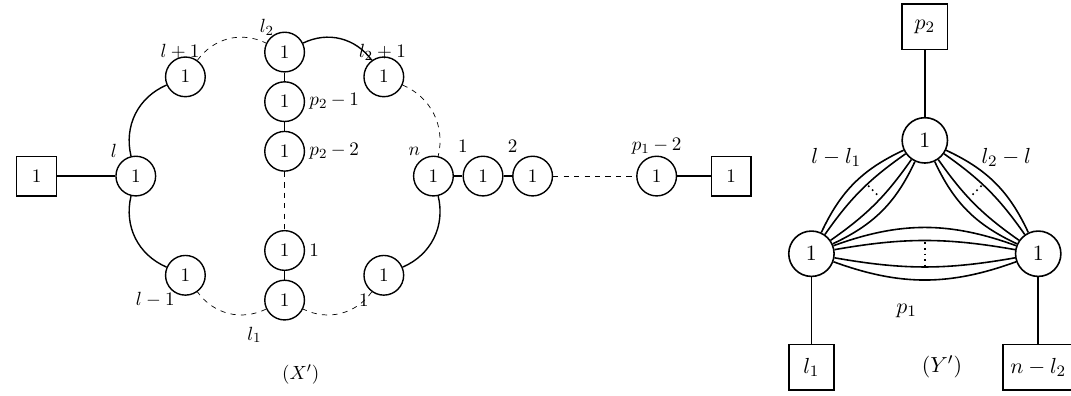
Figure 20 . An infinite family of mirror duals labelled by the positive integers ( n, l, l 1 , l 2 , p 1 , p 2 ) subject to the constraints n > l Moduli space data